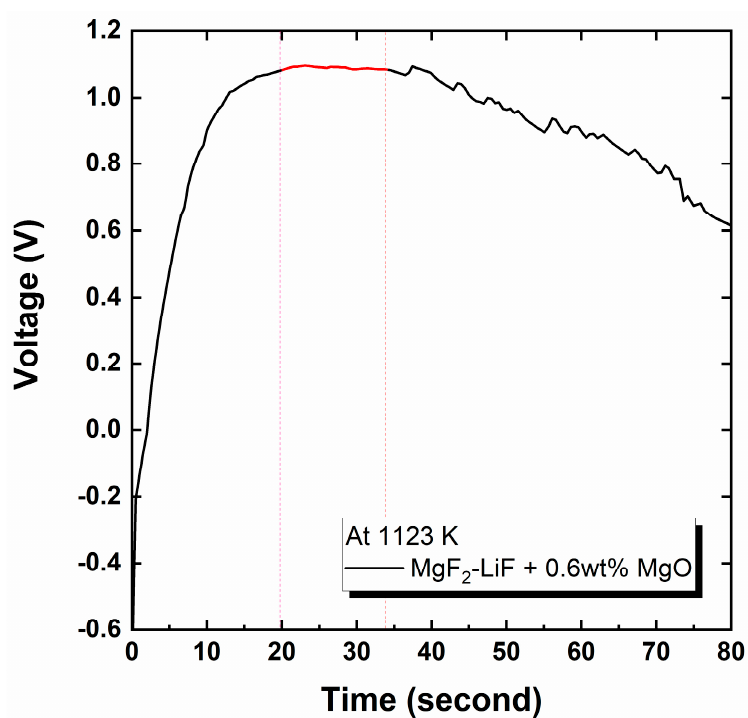
Figure 5. The raw data obtained during the EMF potential measurement. The red line indicates the potential chosen for the calculation of oxygen partial pressure.